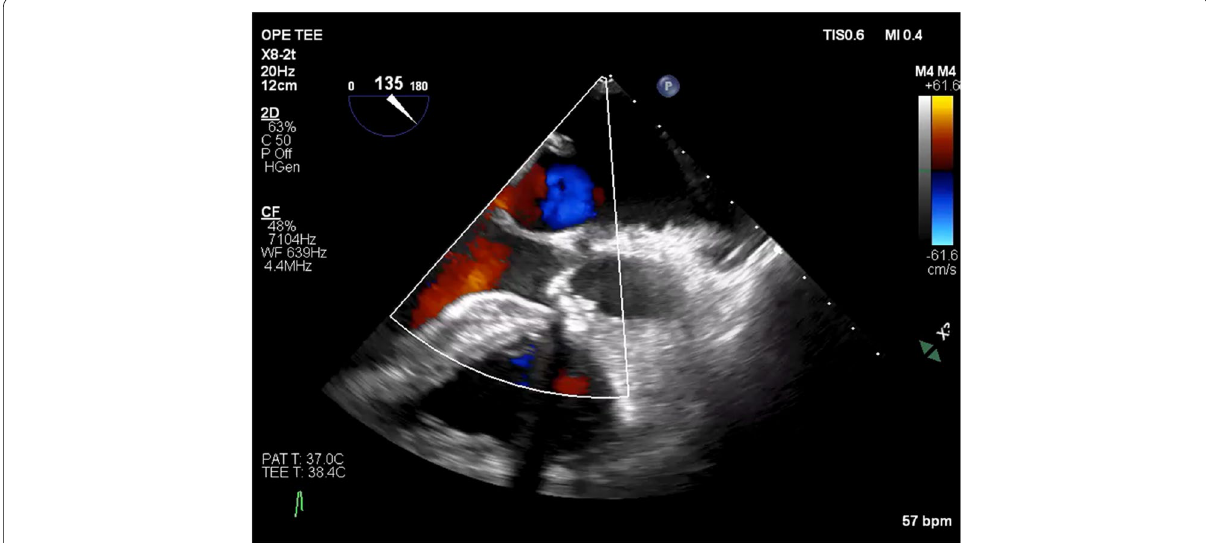
Fig. 2 Intraoperative transesophageal echocardiography (TEE) (pre-deploy). Mid-esophageal long-axis view. Preprocedural examination shows trivial mitral regurgitation. The aortic valve was highly calcified, and transaortic valve color flow Doppler ultrasound shows a mosaic pattern of blood